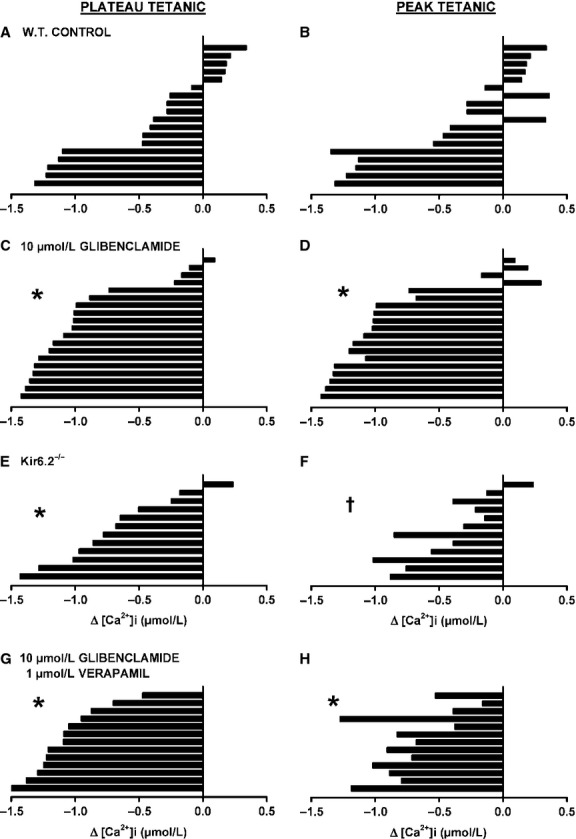
The lack of KATP channel activity increased the number of fibers with large decreases in tetanic [Ca2+]i. Changes in plateau (A, C, E, G) and in peak (B, D, F, H) tetanic [Ca2+]i were calculated as the difference in plateau or peak [Ca2+]i between 0 and 180 sec; a negative value indicates a decreased [Ca2+]i. Each horizontal bar represents a different fiber in the order from the highest increase to the largest decrease in plateau tetanic [Ca2+]i. The same order was maintained for peak tetanic [Ca2+]i. (A, B) wild-type control, (C, D) 10 μmol/L glibenclamide-exposed, (E, F) Kir6.2-/- and (G, H) 10 μmol/L glibenclamide- and 1 μmol/L verapamil-exposed fibers. *Indicate that the proportion of fibers with a decrease in tetanic [Ca2+]i >0.5 μmol/L was significantly different than the proportion for control fibers, †Indicate that the proportion of fibers with a decrease in tetanic [Ca2+]i >0.5 μmol/L was significantly different from the glibenclamide-exposed fibers, Fishers Exact test, P < 0.05.